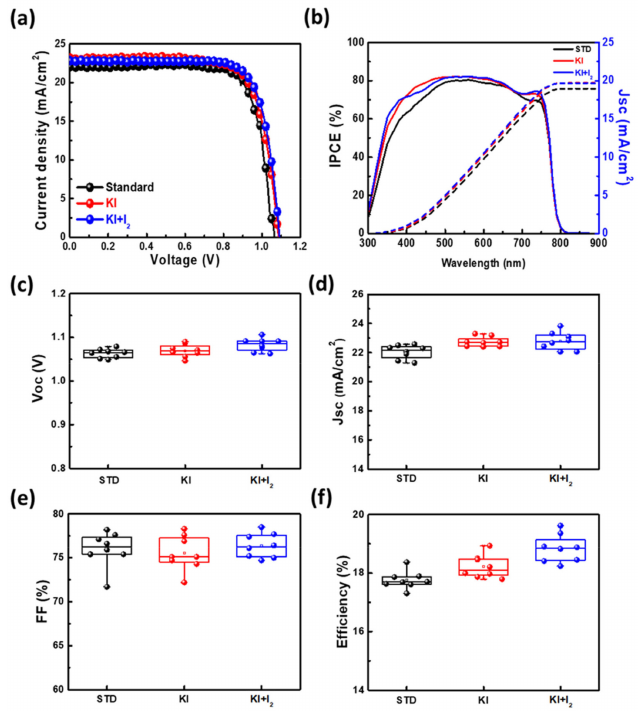
Figure 5. ( a ) J–V curves, ( b ) IPCEs, and ( c – f ) the statistical photovoltaic characteristics of PSCs with various optimal conditions (pristine, KI (30 mM), and KI (30 mM) + I 2 (3 mM)).